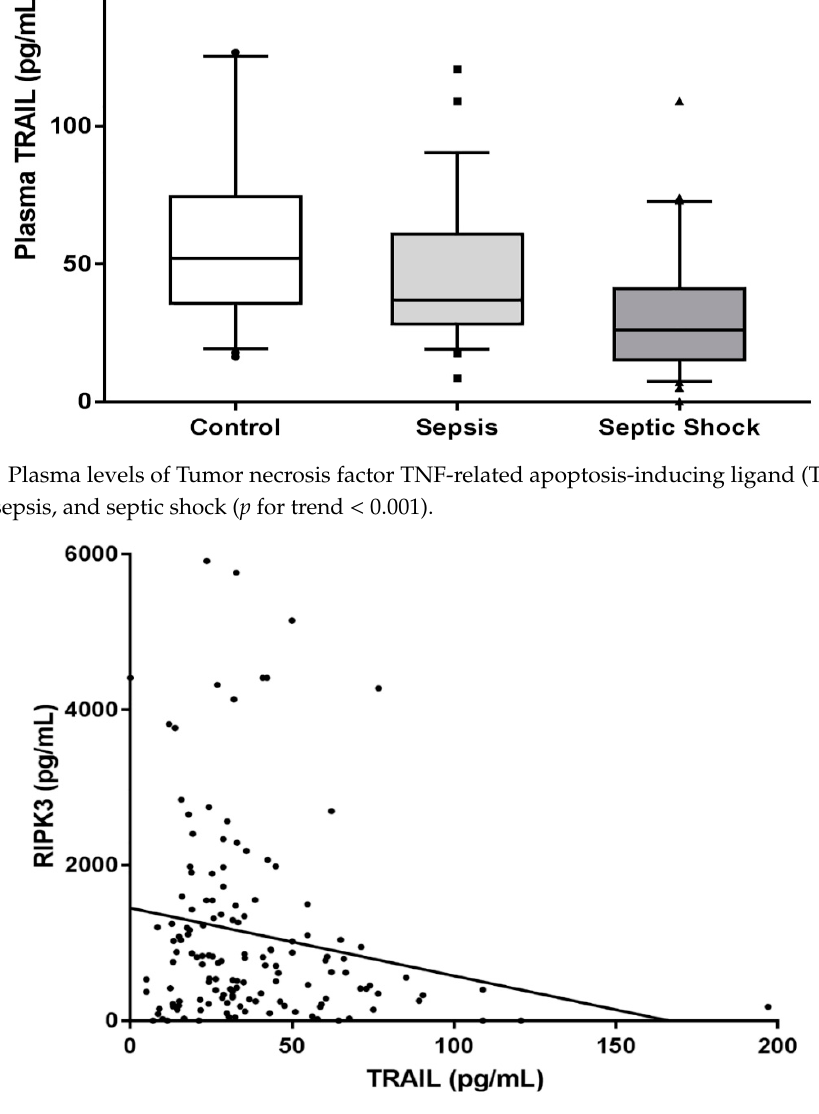
Figure 2. Plasma levels of Tumor necrosis factor TNF-related apoptosis-inducing ligand (TRAIL) in control, sepsis, and septic shock ( p for trend < 0.001).